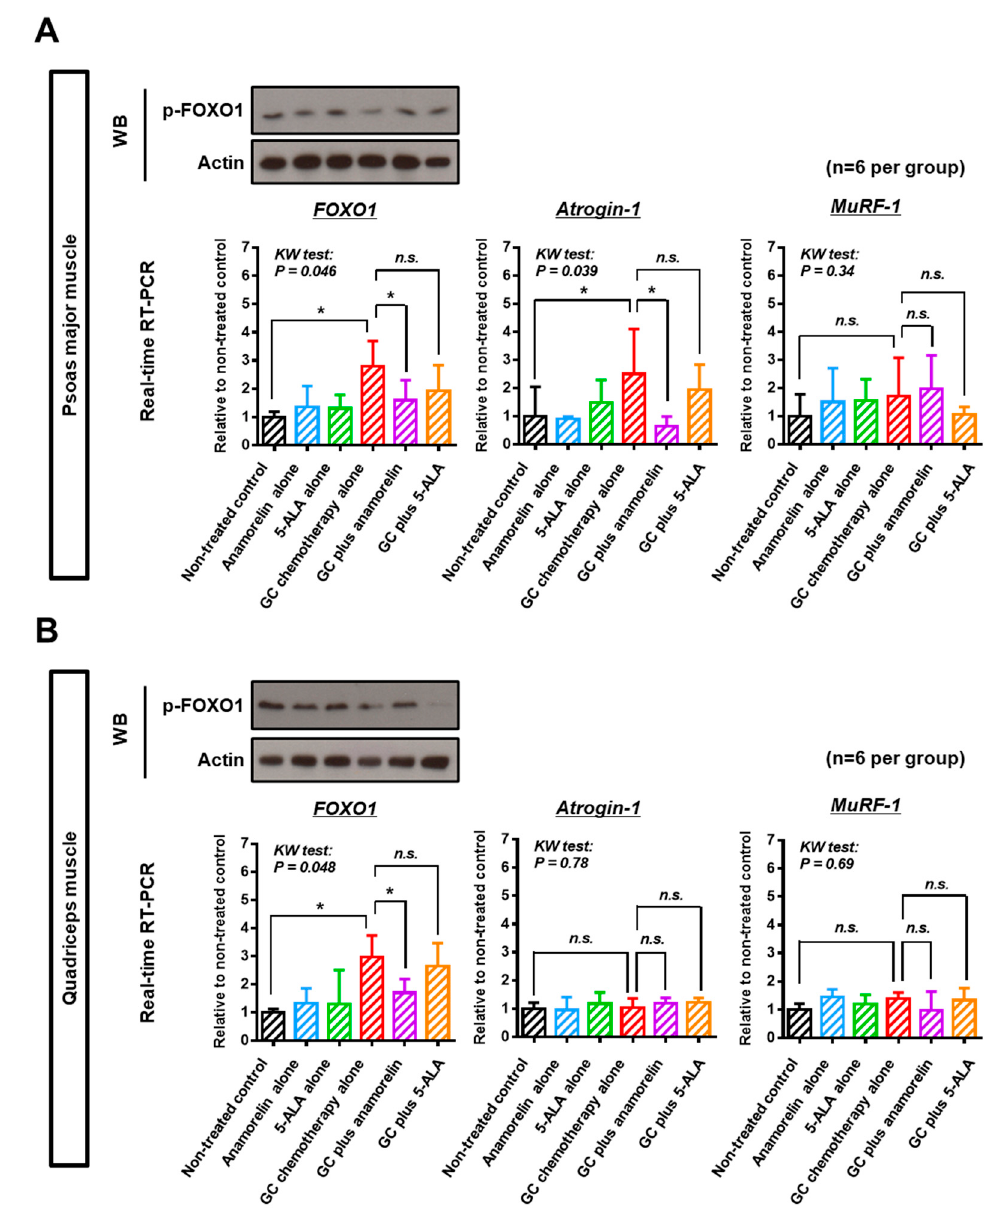
Figure 3. Three muscle atrophy-related genes in the psoas major muscle and quadriceps muscle of treated mice. Phosphorylation level of FOXO1 (p-FOXO1) and gene expressions of total FOXO1, atrogin-1, and MuRF-1 in the psoas major muscle ( A ) and quadriceps muscle ( B ) were determined using Western blotting and quantitative real-time RT-PCR. In the Western blotting analysis, anti-actin antibody was used as an internal loading control. Western blot analysis was performed to evaluate phosphorylation level of FOXO1. Actin served as a loading control. The fold change of the stained muscle mass of each treatment was expressed by relative value to the non-treated control (set to 1). Representative blots are shown in this figure and the results were confirmed in three independent experiments. In the analysis of RT-PCR, the level of each treatment group was expressed as the relative value after normalization with the beta-actin expression level. Marked attention was paid to the relationship among the non-treated control, gemcitabine/cisplatin (GC) chemotherapy alone, and GC plus anamorelin groups. The differences according to the type of treatment were examined using the Kruskal–Wallis test, followed by the Dunn post-hoc test. * p < 0.05, ** p < 0.01, n.s. , not significant.